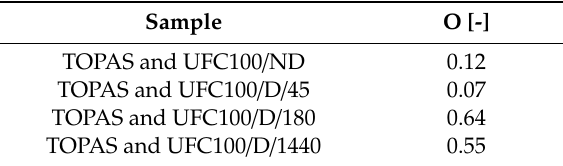
Table 5. Tabularized values of the orientation influence factor for the investigated composites specimens.